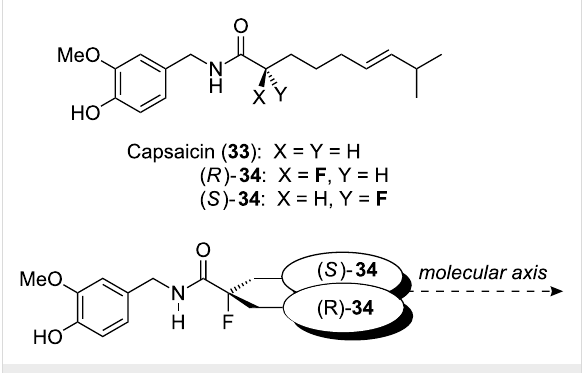
Figure 8: Capsaicin ( 33 ) and fluorinated analogues ( R )- 34 and ( S )- 34